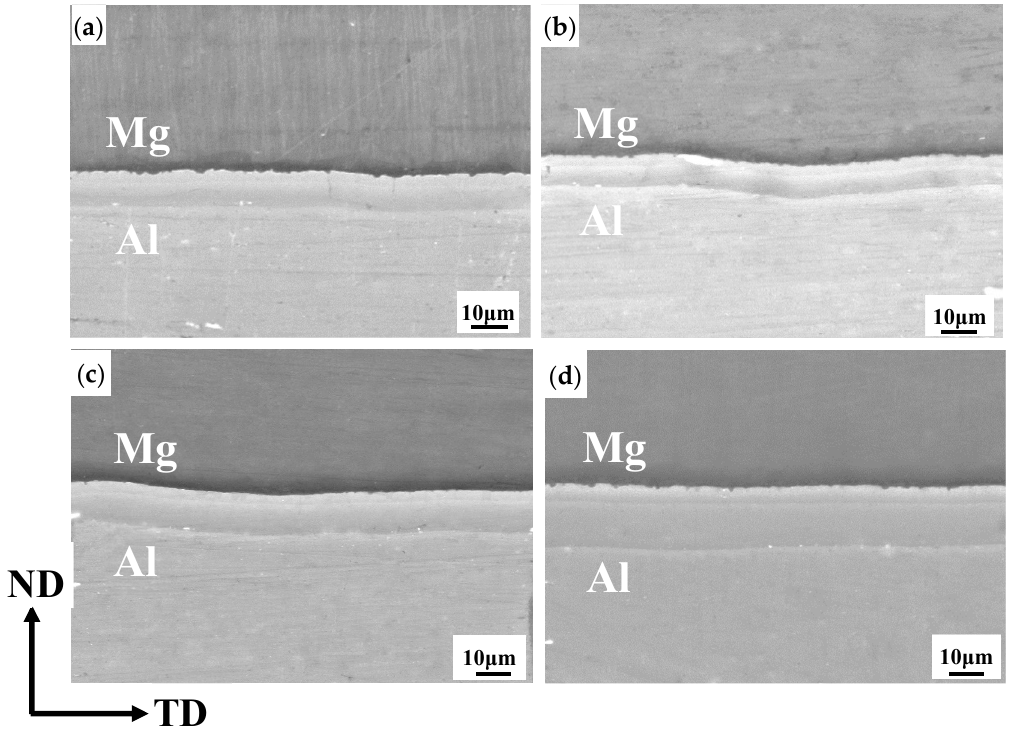
Figure 9. SEM images and elemental surface scanning for CFR flattened Mg / Al laminated composite along TD: ( a ) As-rolled; ( b ) 200 °C; ( c ) 300 °C; and ( d ) 350 °C.